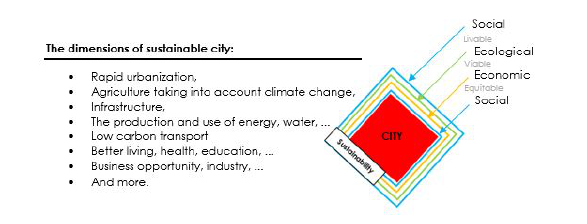
Figure 4. Model of a sustainable